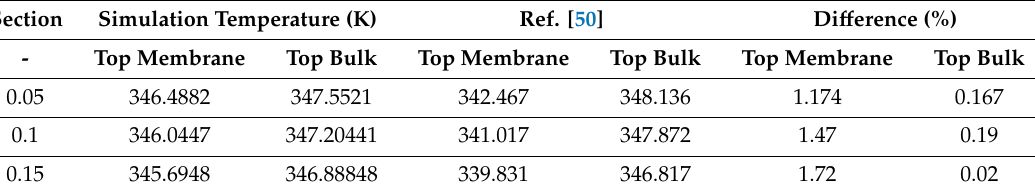
Table 3. Bulk and membrane surface temperatures calculated at Re = 100 against the results reported in the literature